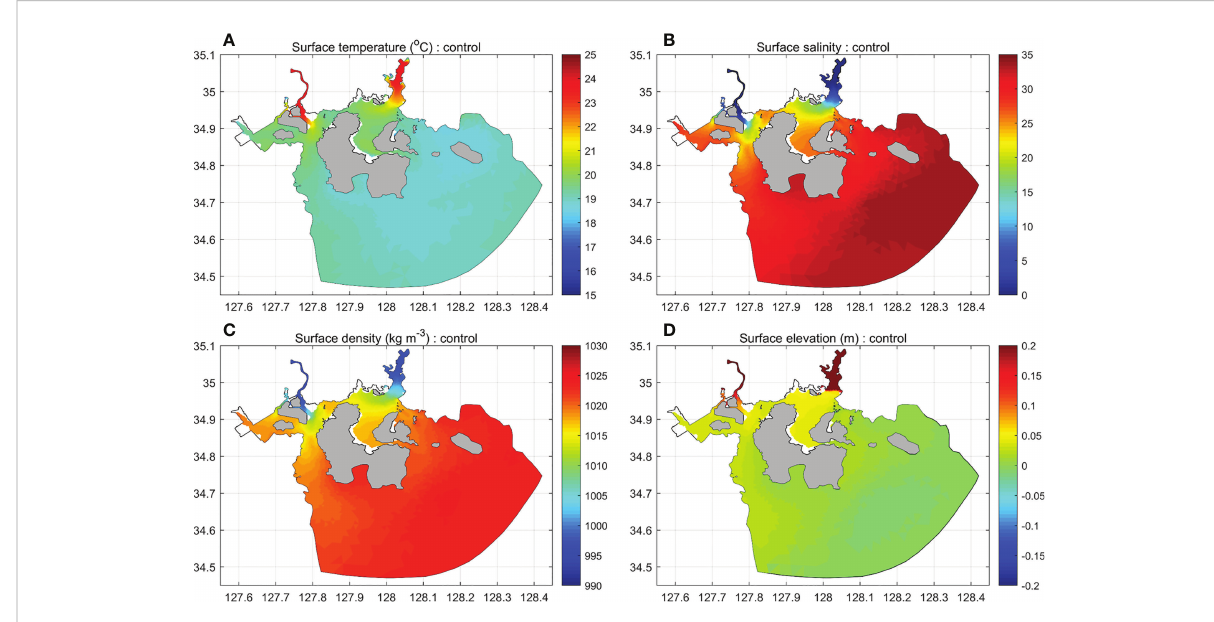
FIGURE 4 Averaged surface: (A) temperature, (B) salinity, (C) density, and (D) elevation results for the control model from 26 June to 24